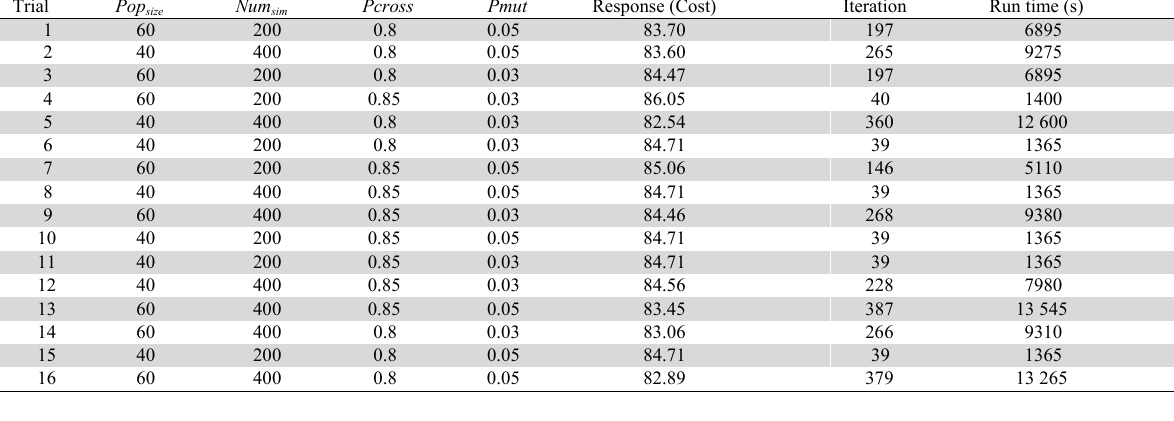
The simulated trials and